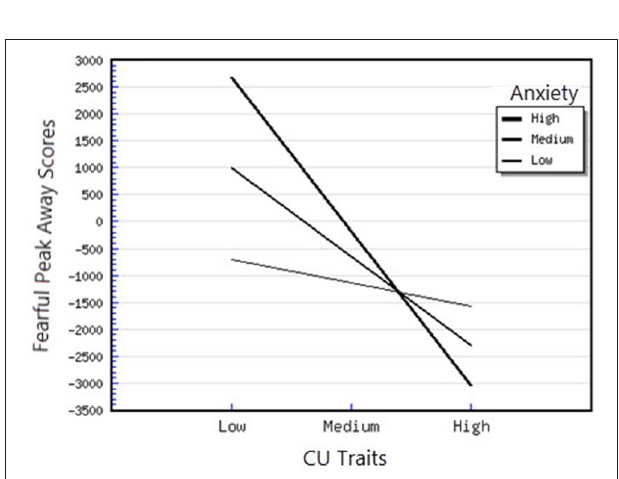
FIGURE 4 | Interaction between CU traits and anxiety in predicting fearful peak away